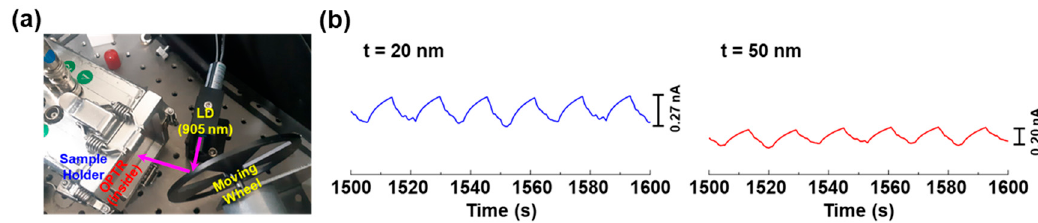
Figure 8. Sensing test for the reflected (scattered) NIR light from an object (moving wheel) using the optimized NIR-OPTRs with the CDS structures: ( a ) photograph for the measurement setup in which the NIR-OPTR is mounted inside the sample holder; ( b ) drain current signals from the NIR-OPTR upon slow moving of the wheel. The initial light intensity from the 905 nm laser diode (LD) was ca. 3.8 mW/cm 2 , while the applied drain and gate voltages were V D = − 30 V and V G = − 30 V, respectively.